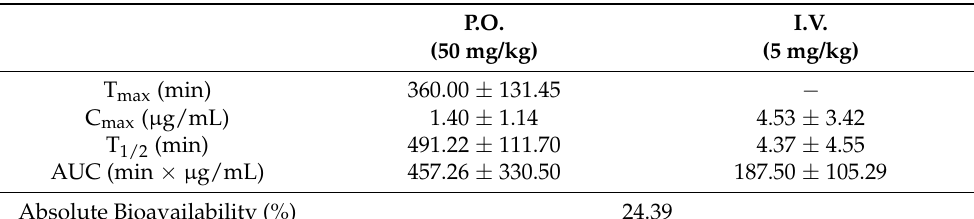
Table 3. Pharmacokinetic parameters of erinacine A in rat plasma after oral administration of H. erinaceus mycelia extract at 2.381 g/kg body weight (equivalent to 50 mg/kg BW of erinacine A) and intravenous administration of erinacine A at 5